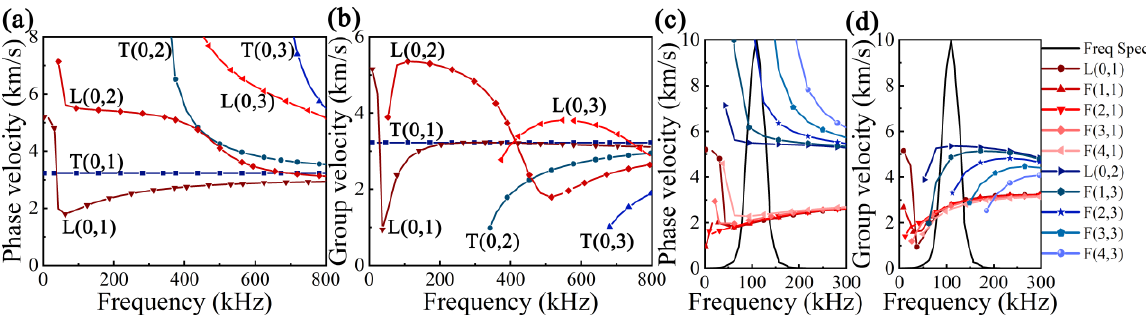
Figure 3. Dispersion curves of the zero-order axisymmetric UGWs: ( a ) phase velocity, ( b ) group velocity and dispersion curves of the asymmetric UGWs: ( c ) phase velocity, ( d ) group velocity. It is almost impossible to not excite T(0, m ) ( m ≥ 1) and L(0, m ) ( m ≥ 3) UGWs when L(0,2) is the desired mode and excitation frequency is 110 kHz, because the